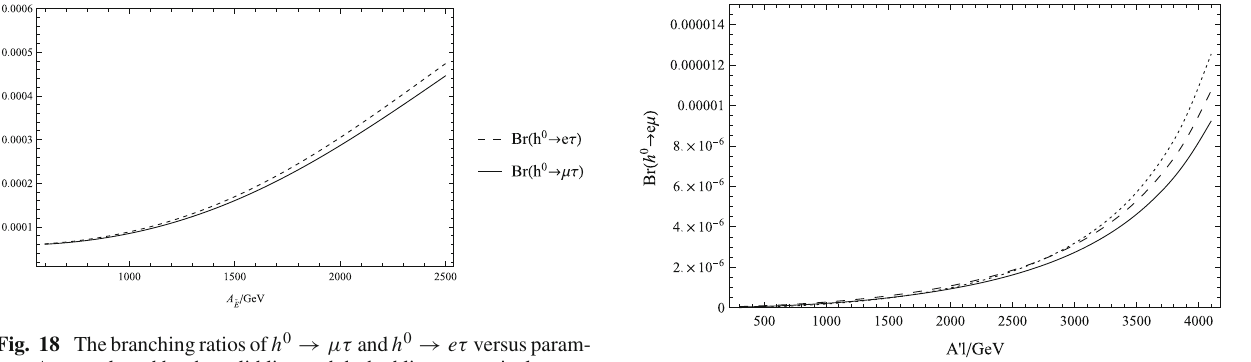
tan β > 9, the numerical results increase quickly. So tan β plays very important roles to CLFV